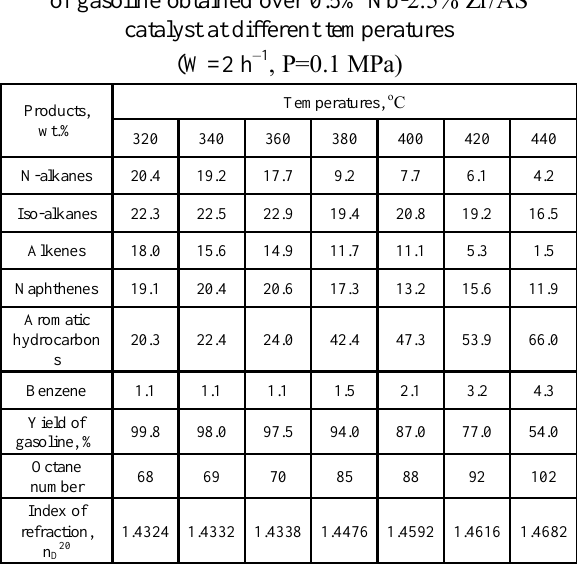
Table 9. Content of product, yield, and octane number of gasoline obtained over 0.5% Nb-2.5% Zr/АS catalyst at different